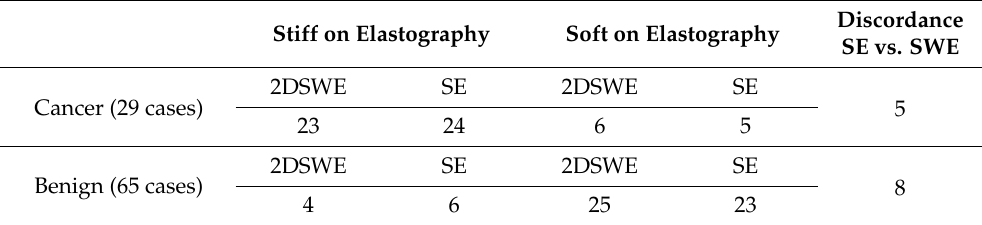
Table 8. Concordance of SE (strain ratio) versus 2D-SWE (Mean EI) in the benign and malignant groups.